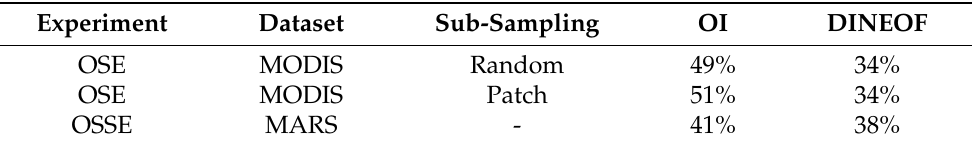
Table 4. Evolution of accuracy, from OI or DINEOF to 4DVarNet, in the form of a performance rate according to the formula 1 − RMSLE(4DVarNet)/RMSLE( · ) expressed in percentage, when using the RMSLE reported in Table